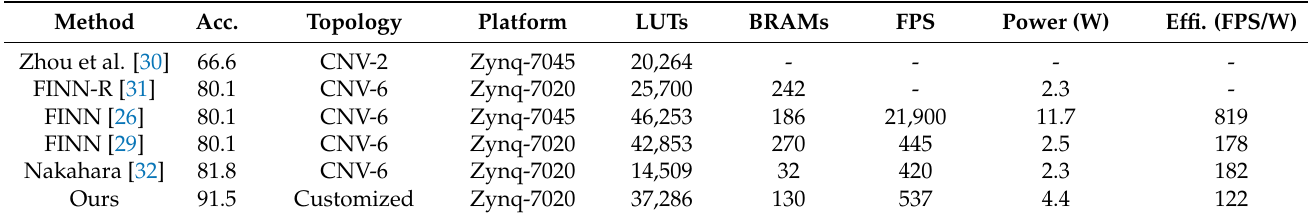
Table 4. Deployment performance of BNNs on CIFAR-10